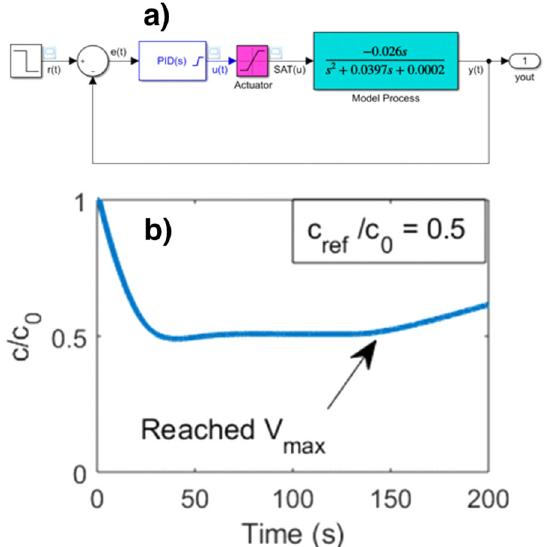
Fig. 6 PID system for CDI. a The Simulink model for the LDL control system. The Model Process determines how the system is affected by the applied voltage, as extracted from the data in Fig. 3. The PID component determines what voltage to apply depending on the output (e.g., the ef fl uent concentration), and the actuator limits the applied voltage to 1.2 V. Also, the PID component contains an anti- windup feature to improve overall performance if the applied voltage reaches its maximum value during parts of the process. b The simulated ef fl uent concentration when the operator applied a reference signal c ref / c 0 = 0.5, meaning the device is supposed to produce outlet water with half the concentration of the inlet